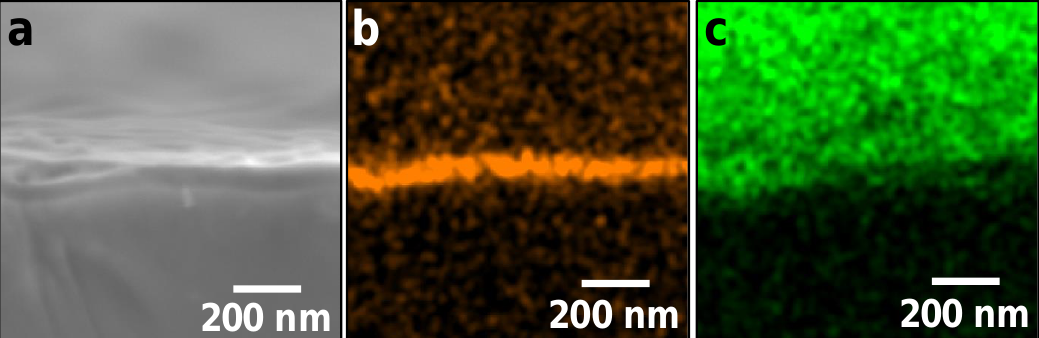
Figure 6. SE image and corresponding EDX elemental analysis of SiO 2 /ZrO 2 ‑coated substrates. Both SiO 2 ‑ and ZrO 2 ‑coating processes were carried out three times. ( a ) SE image; and ( b ) and ( c ) elemental maps of Si (orange) and Zr (green), respectively. The sample was the same as that in Figure 5(b2).